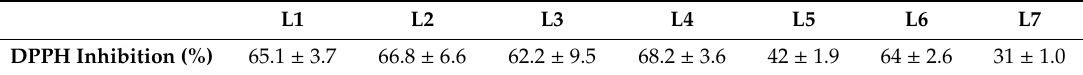
Table 4. The DPPH inhibitions of kraft lignin fractions (L1 to L4) and organosolv lignins obtained from spruce / pine (L5), beech (L6), and Miscanthus x giganteus (L7). L1